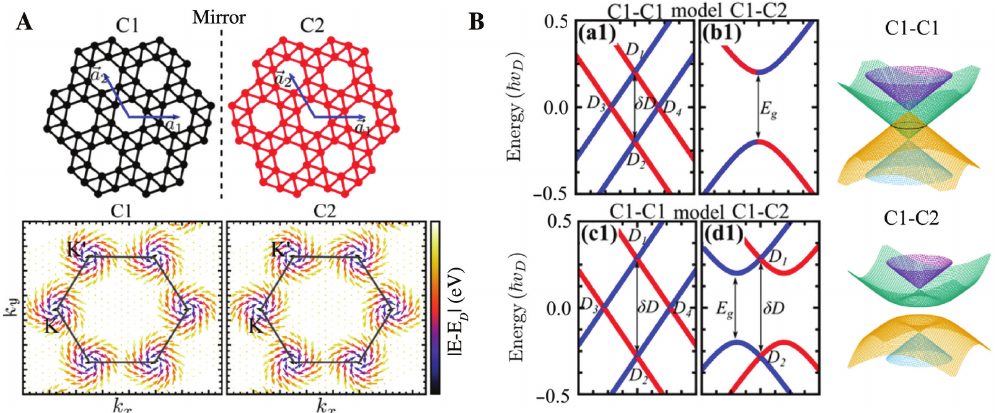
Figure 4: The orbital texture for borophene. (A) The atomic structure and the orbital texture for the Dirac cone of the borophene ( χ - h texture model of bilayer borophene with same chirality stacking (C1–C1) and opposite chirality stacking (C1–C2) before and after applied electric field. Right: 3D band structure for the same chirality stacking (C1–C1) and opposite chirality stacking (C1–C2) under electric field. Reproduced with permission [79]. Copyright 2019, American Chemical Society.